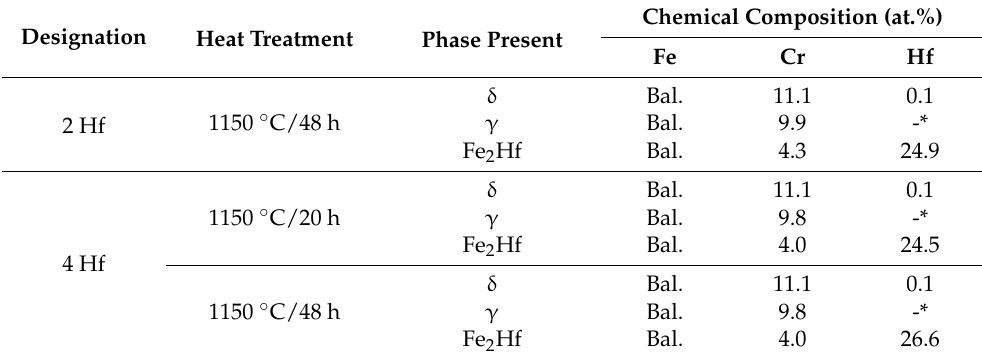
Table 3. The analyzed chemical compositions of the phases present in the Hf-doped ternary alloys after heat treatments, followed by water quenching.